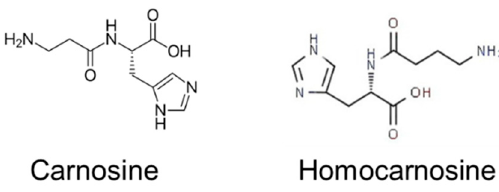
Figure 6. Carnosine and homocarnosine.